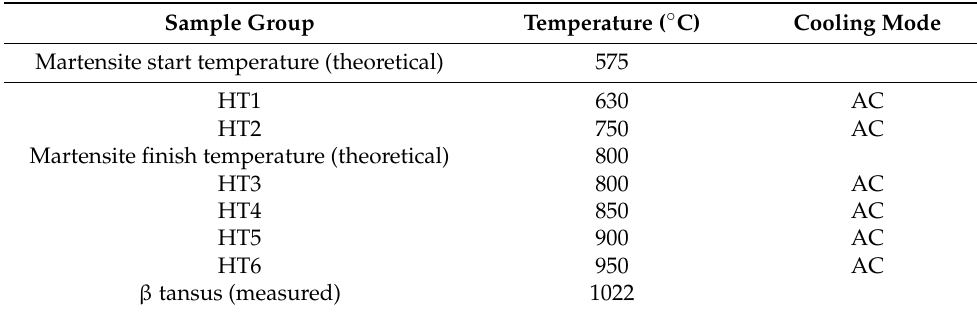
Table 2. Key temperature measured for the studied L-PBF TA15 and heat treatments applied in this